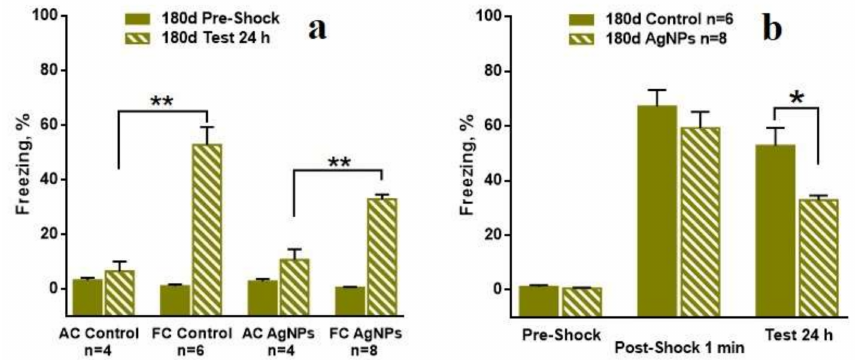
Figure 13. Number of the freezing acts in the freezing chamber for “180 day” group of mice. ( a ) demonstrates the quality of learning for the Ag-NP groups and the reference groups between the FC and the AC; ( b ) is the comparison in the learning and the formed contextual memory between Ag-NP groups and the reference groups. Reliable degradation of the contextual memory for Ag-NP group can be seen for the testing at 24 h after the exposure, which is performed by the number of freezing act’s